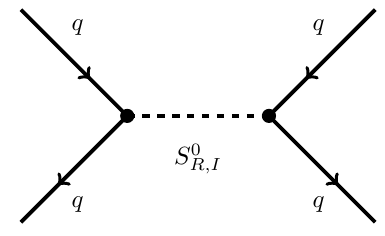
Figure 7 . Four-quark contribution from the neutral scalars S 0